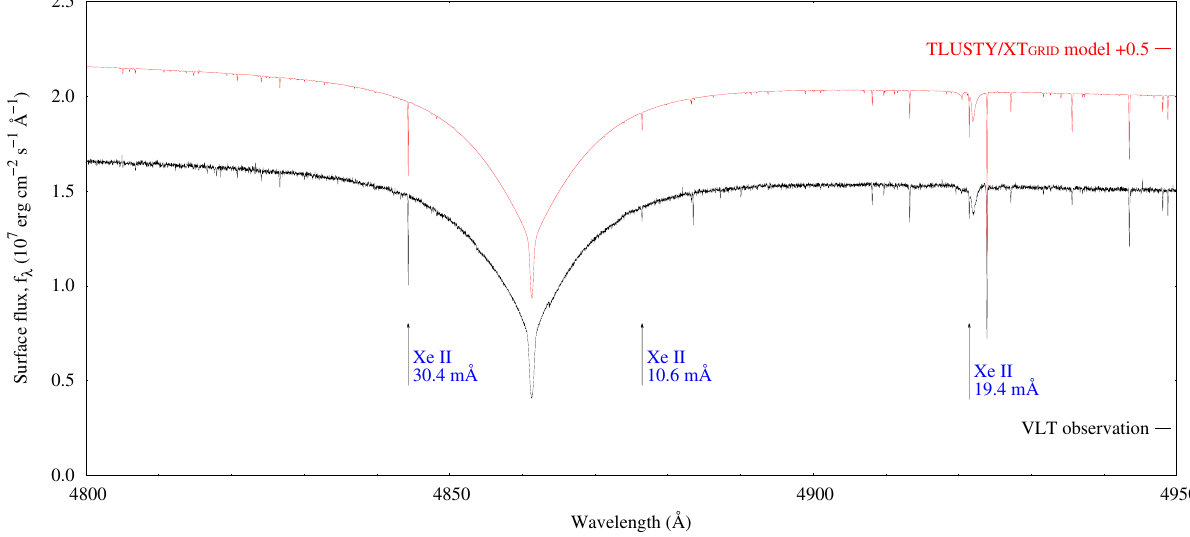
Figure 3. The VLT/UVES observation of Feige86 reveals strong lines of Xe ii in the optical. The three spectral lines of Xe ii that have an equivalent width larger than 10 mÅ in the 4800-4950 Å spectral range are marked with blue labels. All lines of Xe are marked in the online version.